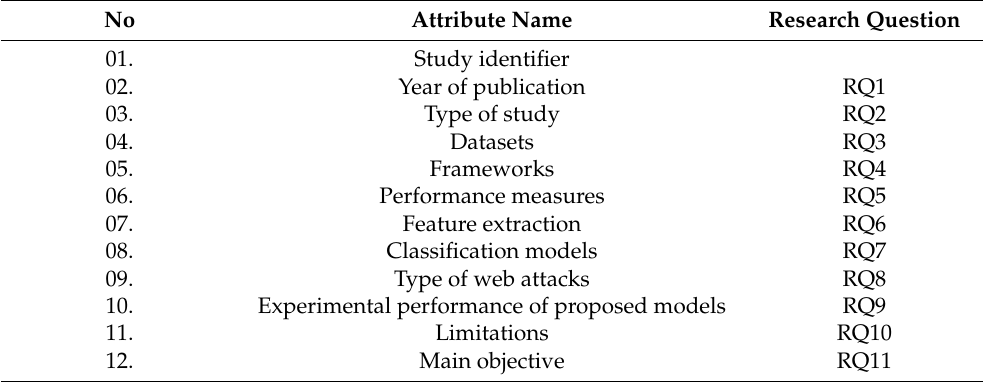
Table 4. Data extraction